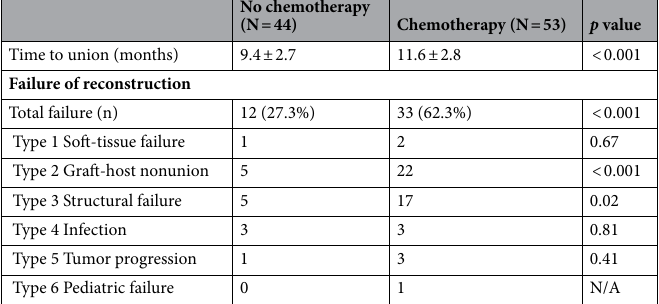
Table 4. Subgroup analysis of patients according to the use of chemotherapy. N/A Not